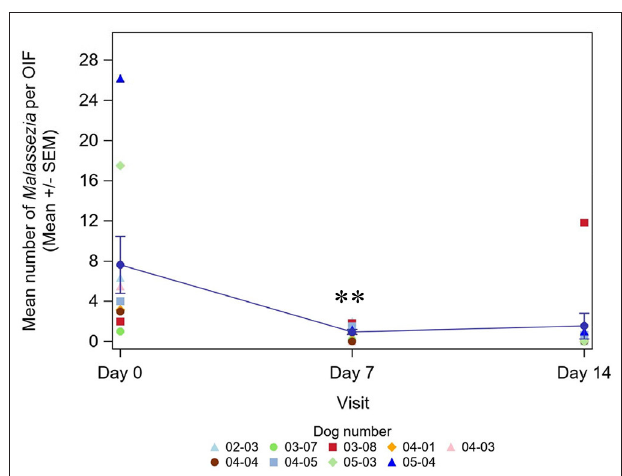
FIGURE 2 | Evolution of the mean number of Malassezia per OIF at each visit with individual data by dog ( n = 9)—Line plot. **Results are significantly different from D0 ( P <